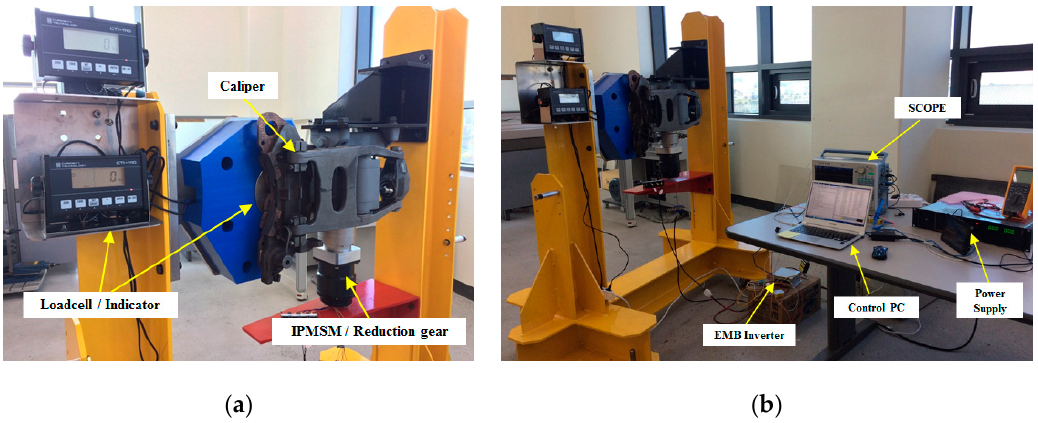
Figure 14. EMB performance test rig: ( a ) clamping force measurement and ( b ) EMB control setup.